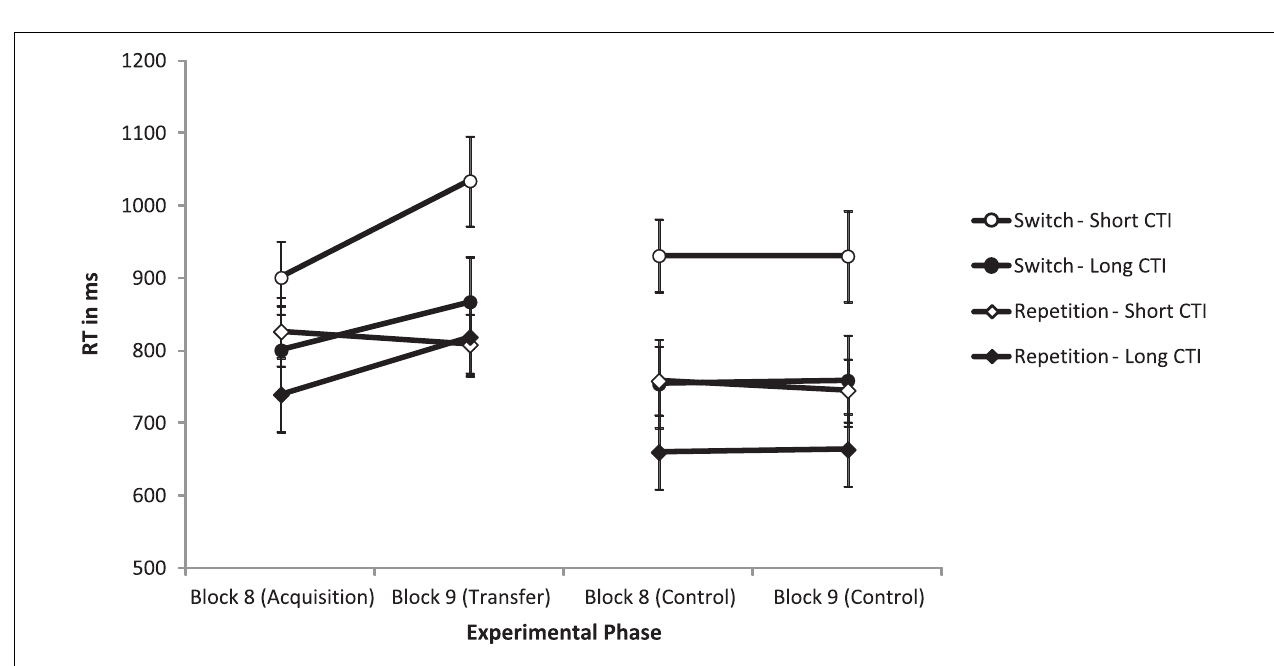
FIGURE 1 | Mean reaction times (RT) in ms as a function of task transition, experimental phase, group, and cue-target interval (CTI).